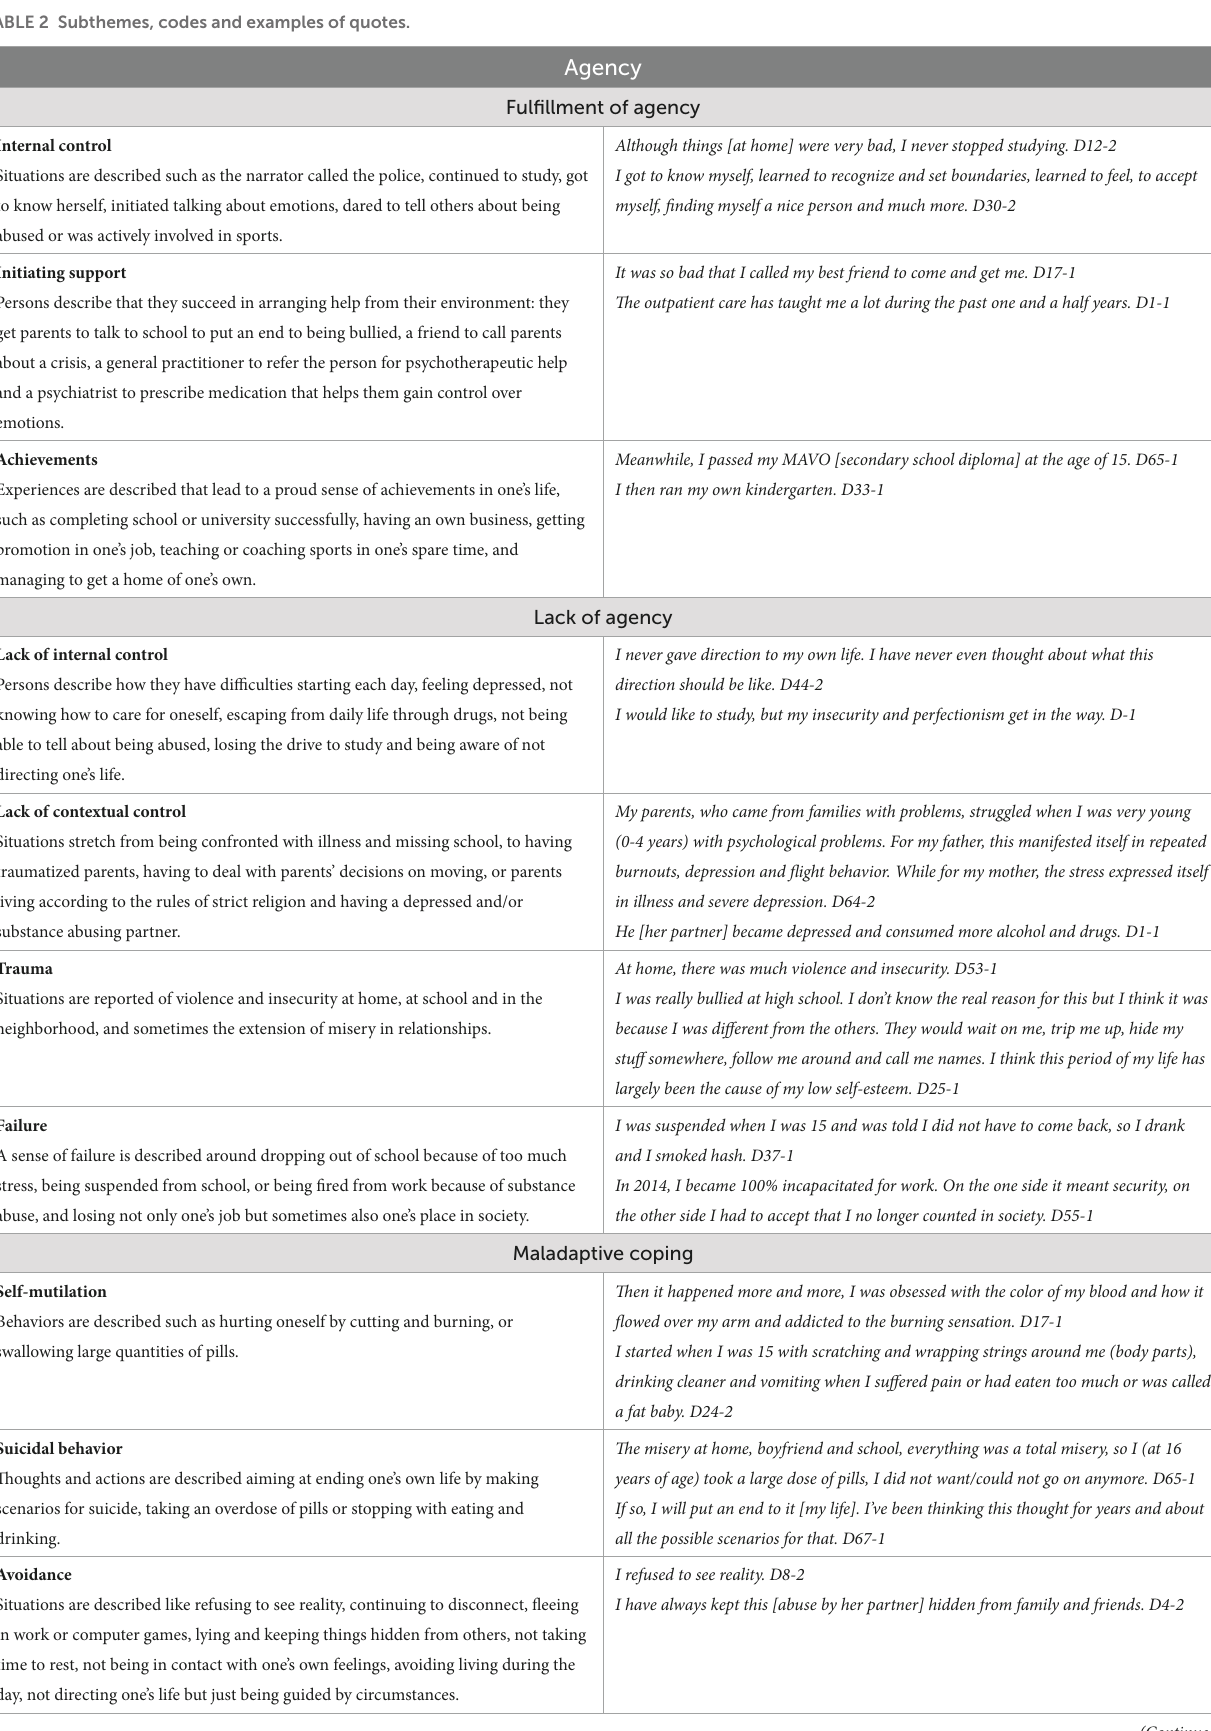
TABLE 2 Subthemes, codes and examples of quotes.